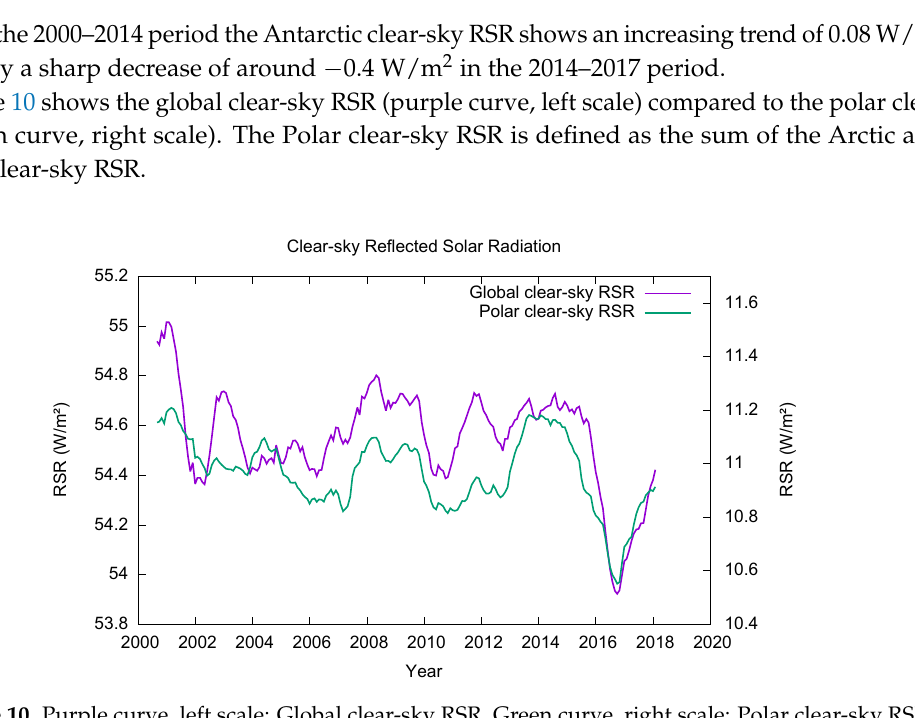
Figure 10. Purple curve, left scale: Global clear-sky RSR. Green curve, right scale: Polar clear-sky RSR. The correlation between the global and the polar clear-sky RSR is 80%. This confirms our previous impression (see Figure 5) that the dominant clear-sky RSR changes occur in the polar regions.